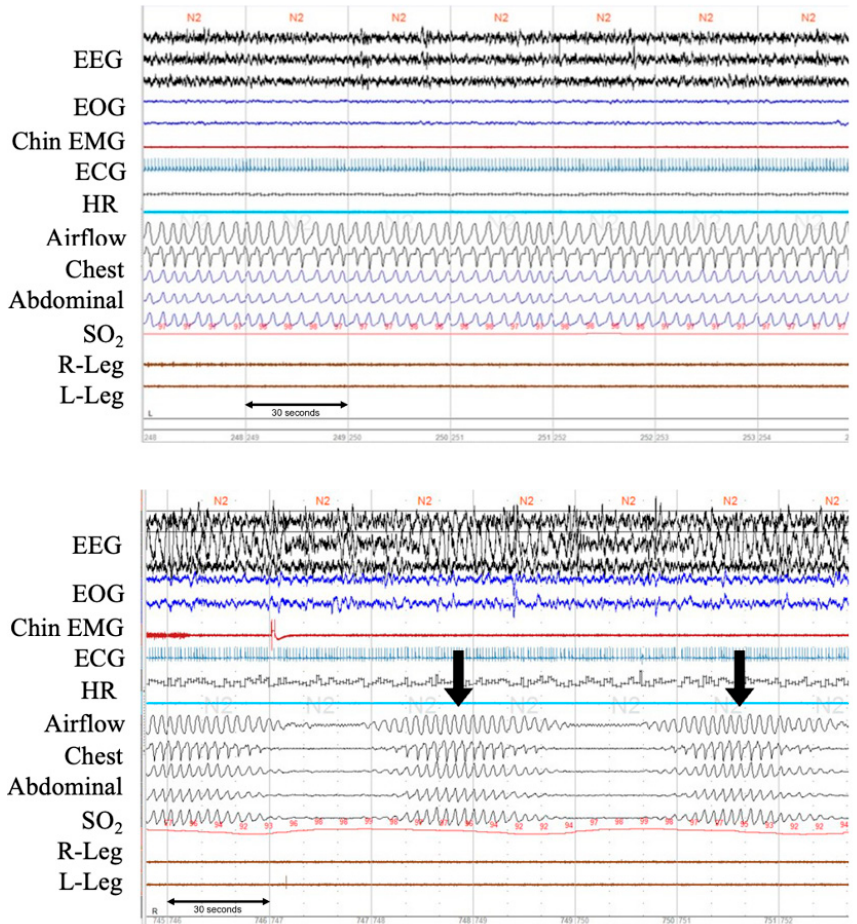
Figure 2. Polysomnographic recordings of normal breathing pattern and a clear pattern of CSR from patients with ADHF. The upper panel shows normal respiration during stage 2 sleep. The lower panel shows Cheyne-Stokes respiration with central sleep apnea. Note in-phase gradual crescendo and decrescendo of tidal volume during hyperpnea and only minimal O 2 desaturation during hypopnea. EEG, electroencephalogram; EOG, electrooculogram; EMG, electromyogram; ECG, electrocardiogram; HR, heart rate; SO 2, oxygen saturation. Arrows ( ↓ ) indicate arousals.